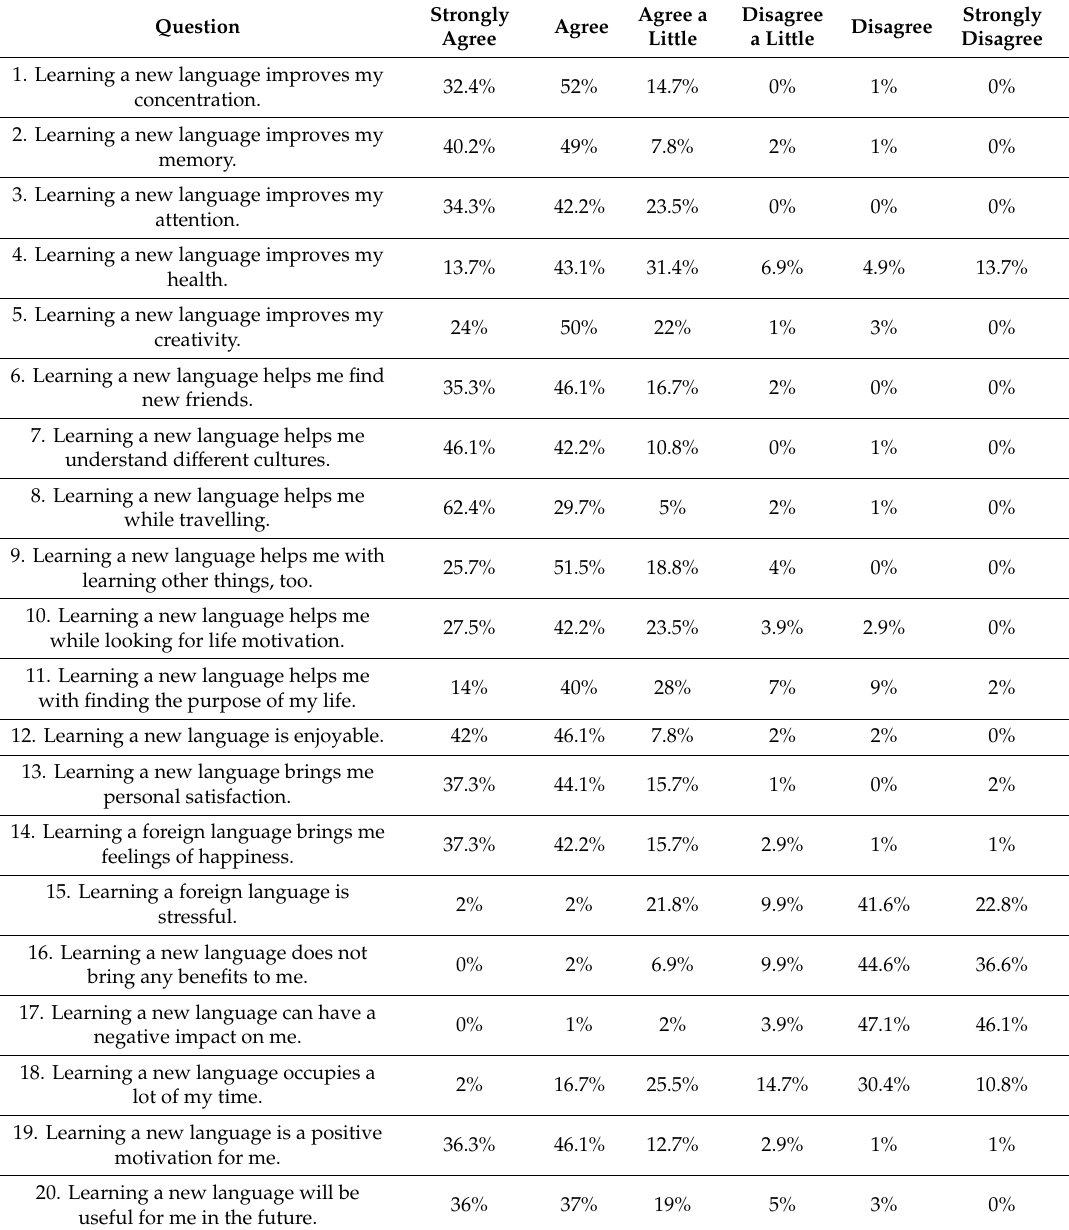
Table 1. An overview of the questionnaire results of the experimental